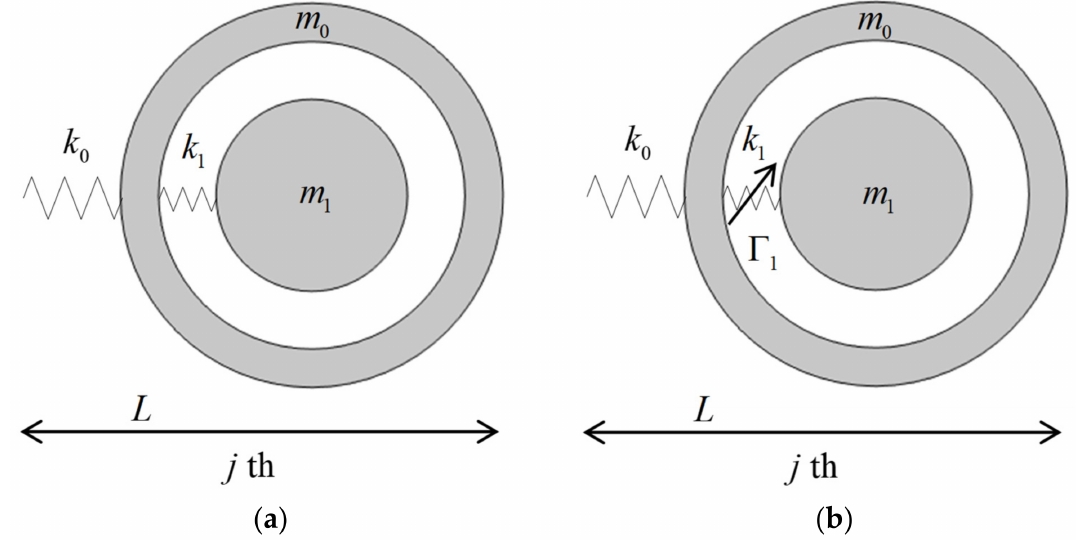
Figure 1. ( a ) Linear and ( b ) nonlinear mass-in-mass lattice